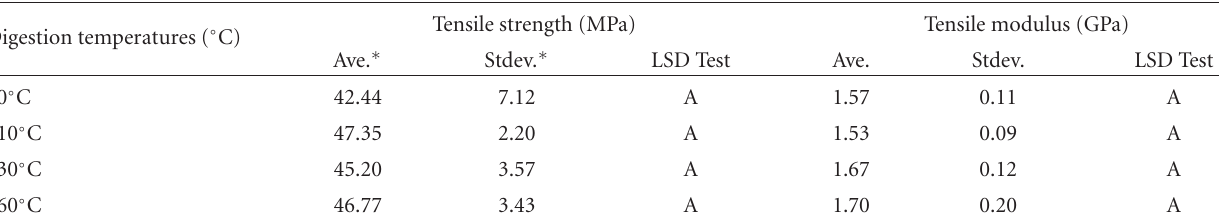
Table 5: Tensile properties of the kenaf fiber/PP